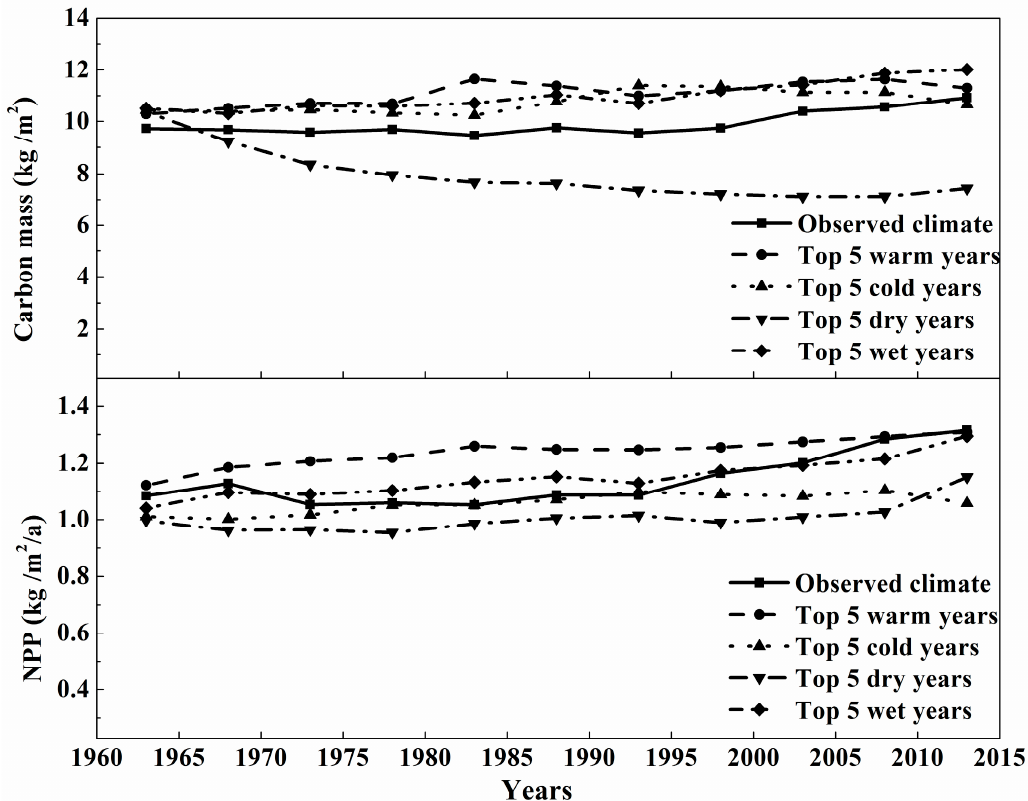
Figure 7. LPJ-GUESS output showing the effects of extreme weather conditions on stored carbon (top panel) and NPP (bottom panel). Local weather data were used to determine the most extreme high /low temperature and high/low rainfall from a 5-year period.